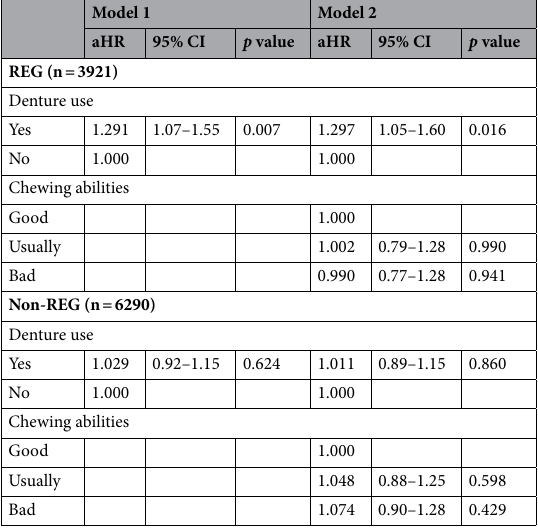
Table 2. Adjusted hazard ratios and 95% confidence intervals for the associations between denture use and all-cause mortality in middle aged and older adults from the Korean Longitudinal Study of Aging 2006–2018. aHR Adjusted hazard ratio, CI Confidence interval, p value using Cox model, REG Regular exercise group. All models were adjusted for age, education, sex, marital status, working restriction, health insurances, alcohol consumption, number of chronic diseases, and self-rated health.